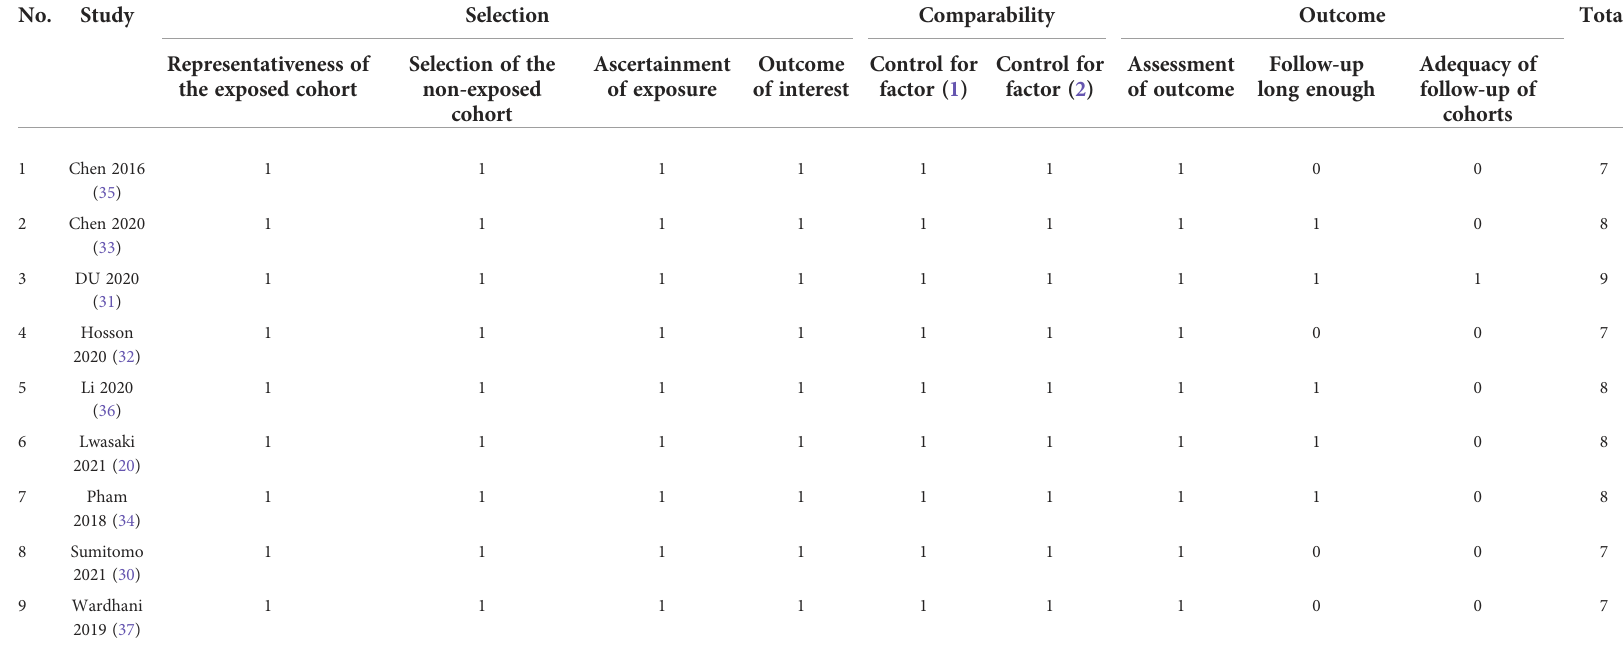
TABLE 3 Newcastle – Ottawa Scale quality assessment of the enrolled